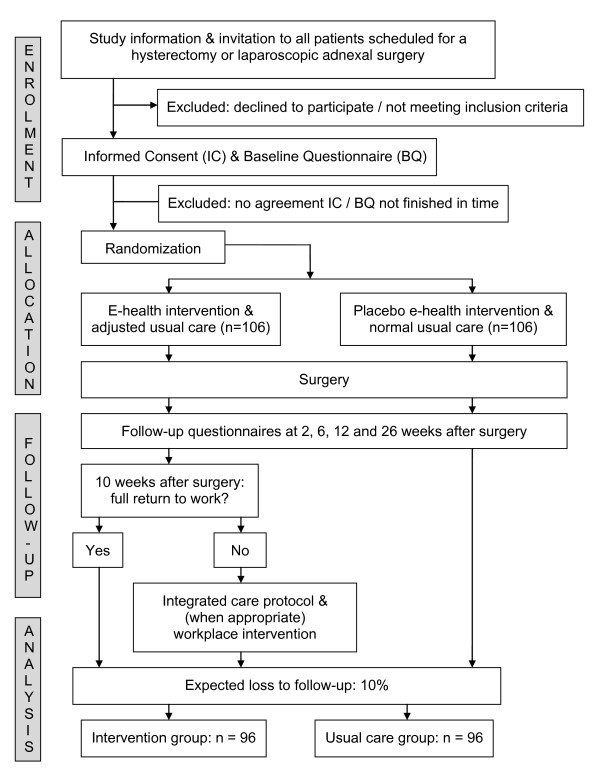
Design of the RCT.